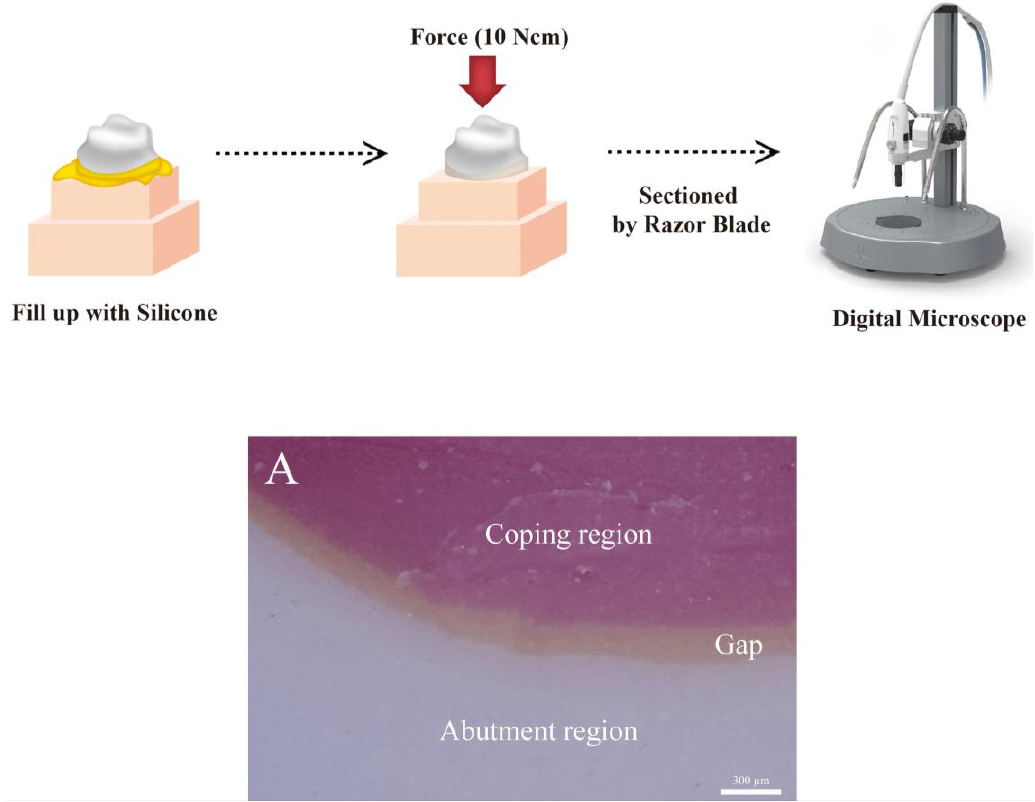
Figure 5. Schematic of the silicone replica technique (SRT). ( A ) Cross-sectional image of SRT for the occlusal gap.